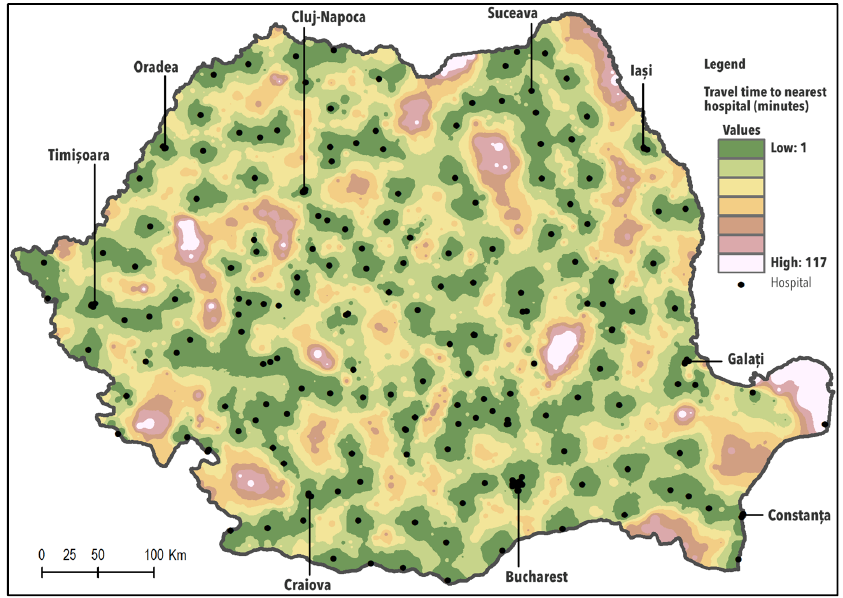
Figure 2. Access to hospitals (all categories).